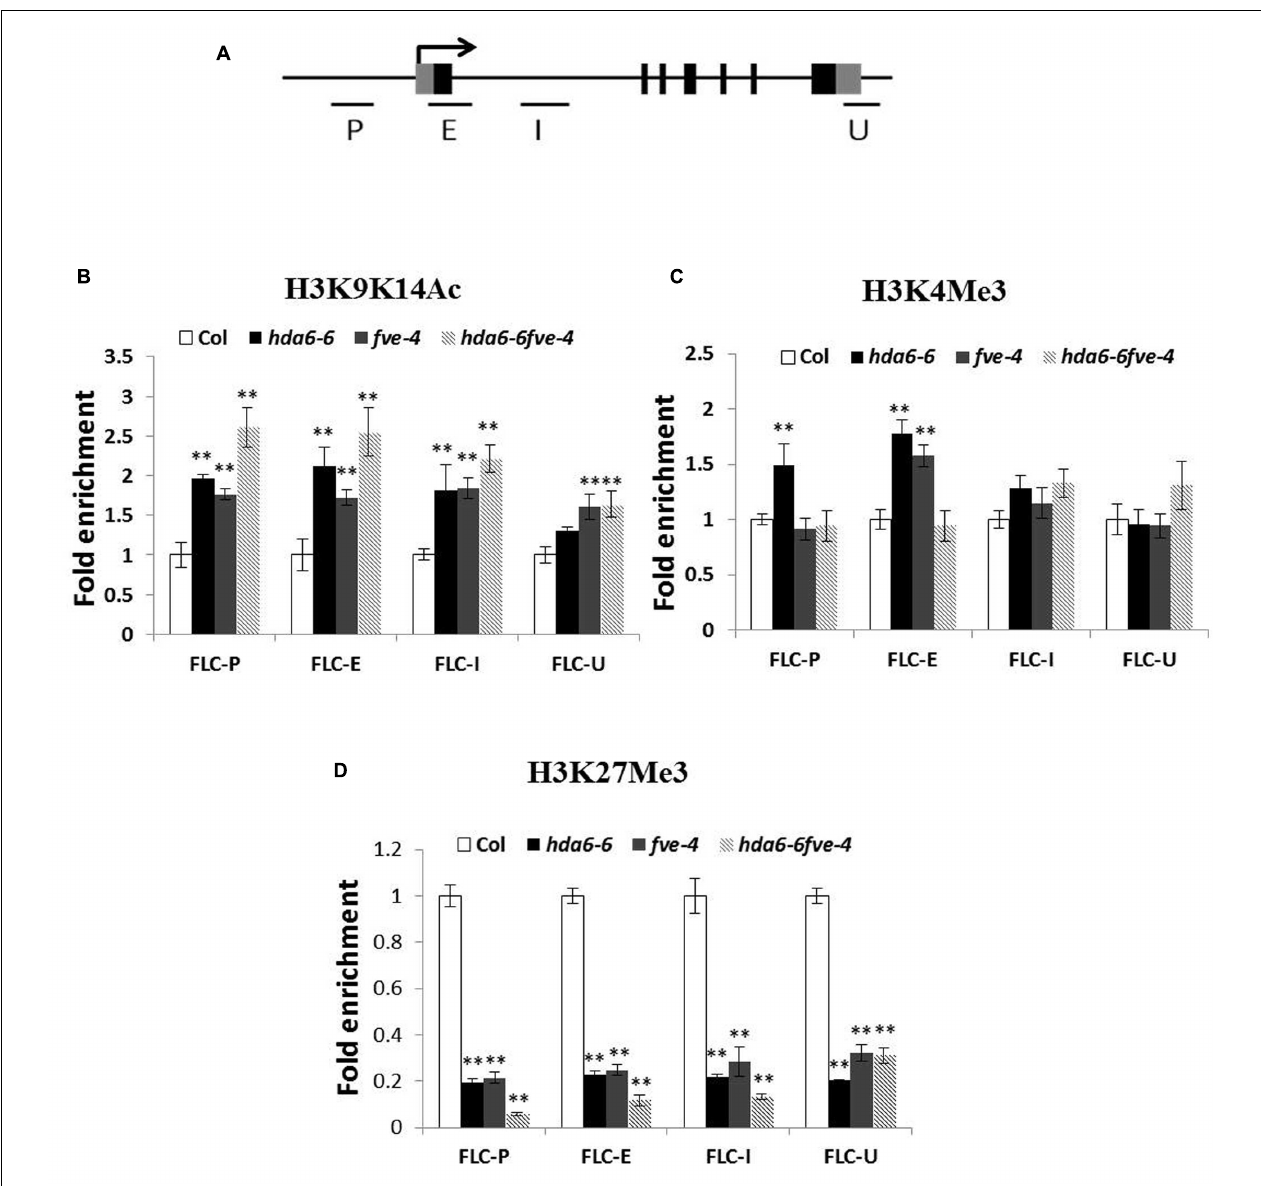
FIGURE 3 | Histone modification levels of FLC chromatin in hda6-6 , fve-4, and hda6-6fve-4 mutants. (A) Schematic structure of genomic sequences of FLC and the regions examined by ChIP. (B–D) Relative levels of H3K9K14Ac (B) , H3K4Me3 (C) , and H3K27Me3 (D) of FLC in Col, hda6-6 , fve-4 , and hda6-6 fve-4 seedlings grown under LD condition for 10 days. ∗∗ Double asterisks denote statistical significance P < 0.01 ( t